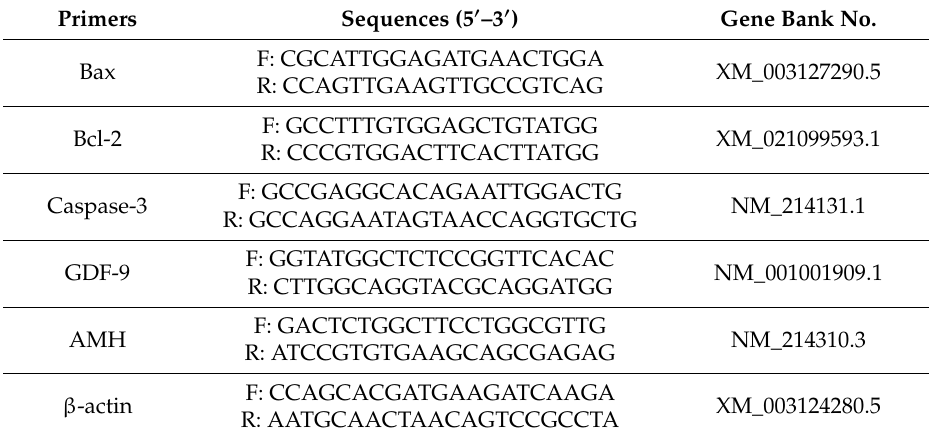
Table 3. Oligonucleotide primers used for real-time quantitative PCR analysis.